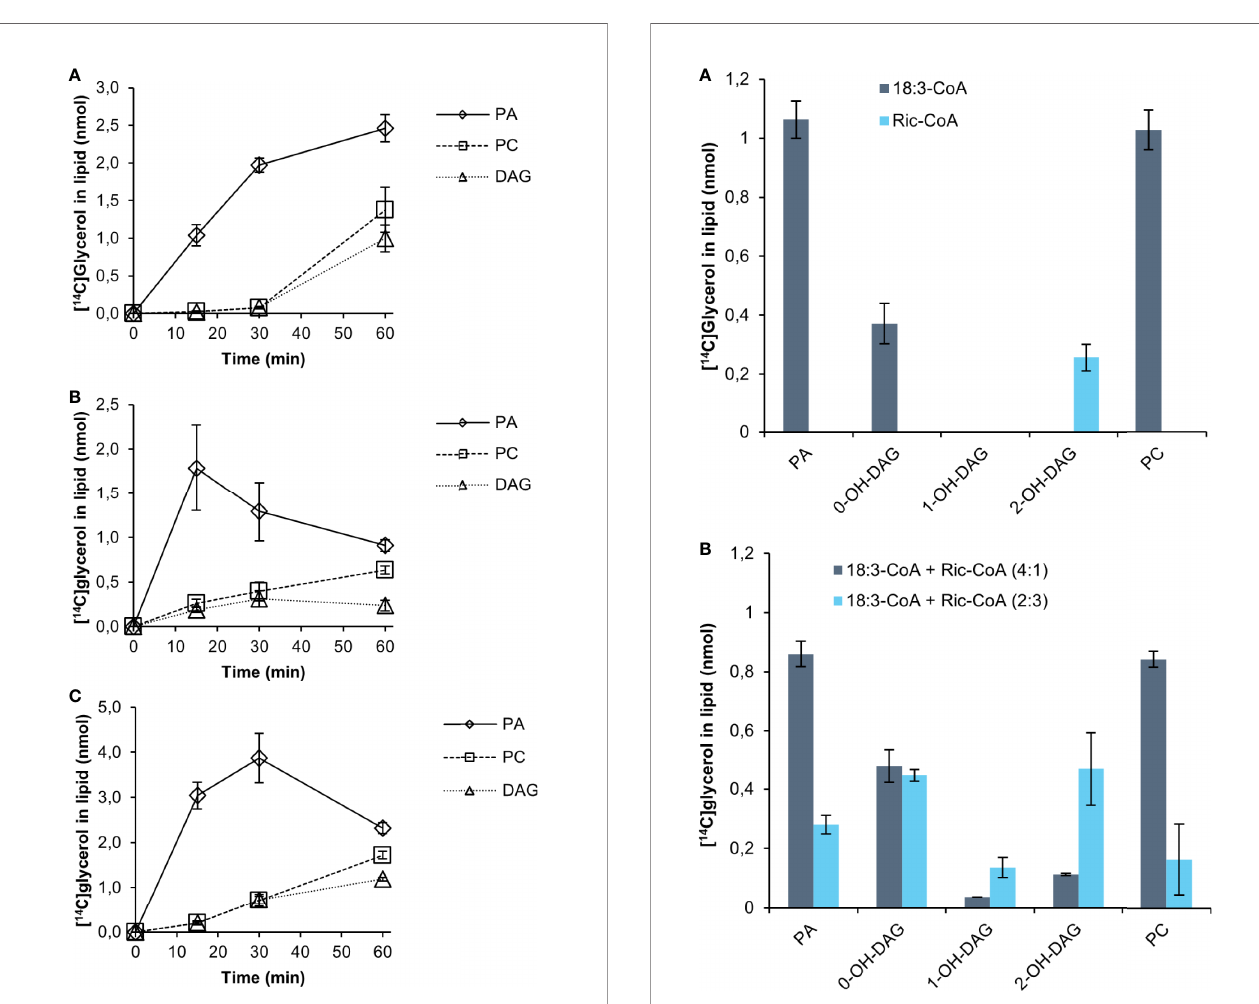
FIGURE 7 | Incorporation of radioactivity into chloroform soluble lipids in microsomal fractions of yeast expressing C. sativa PDCT fed [ 14 C]glycerol labeled G3P and 18:3-CoA and or ricinoleoyl-CoA. (A) 18:3-CoA and ricinoleoyl-CoA (Ric-CoA) as indicated in the fi gure. (B) Mixtures of 18:3 and Ric-CoA in proportions indicated in the fi gure. Incubation time was 60 min. PA, phosphatidic acid; PC, phosphatidyl-choline; DAG, diacylglycerol. Average value shown ± SD, n = 3